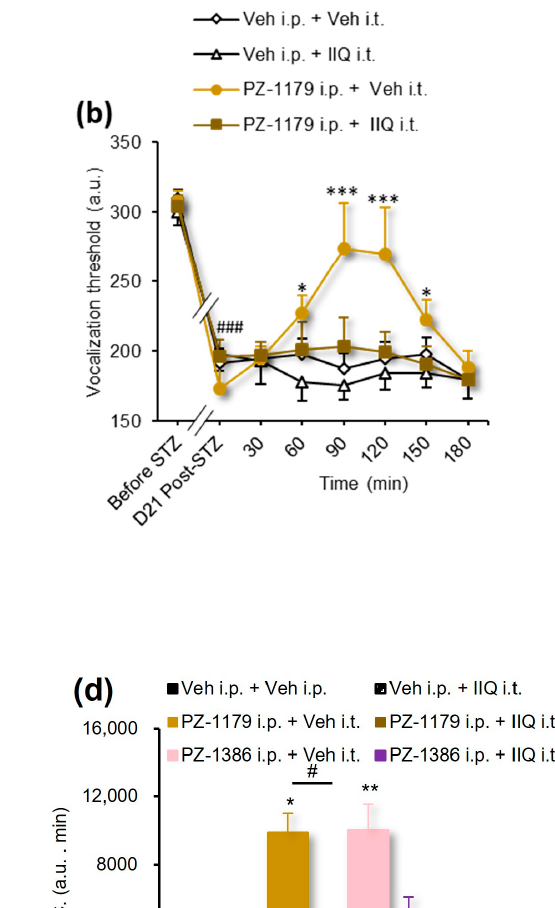
(Figure 3a, Table 1). The maximum effect observed at 120 min (297.5 ± 23.4 a.u.) with rapamycin 10 nmol corresponds to a complete reversal of mechanical hyperalgesia (pain improvement of 114 ± 44%). The dose-dependent effect of rapamycin was illustrated by the A.U.C. of changes in the vocalization threshold measured between 0 and 180 min (Figure 3b, Table 1).